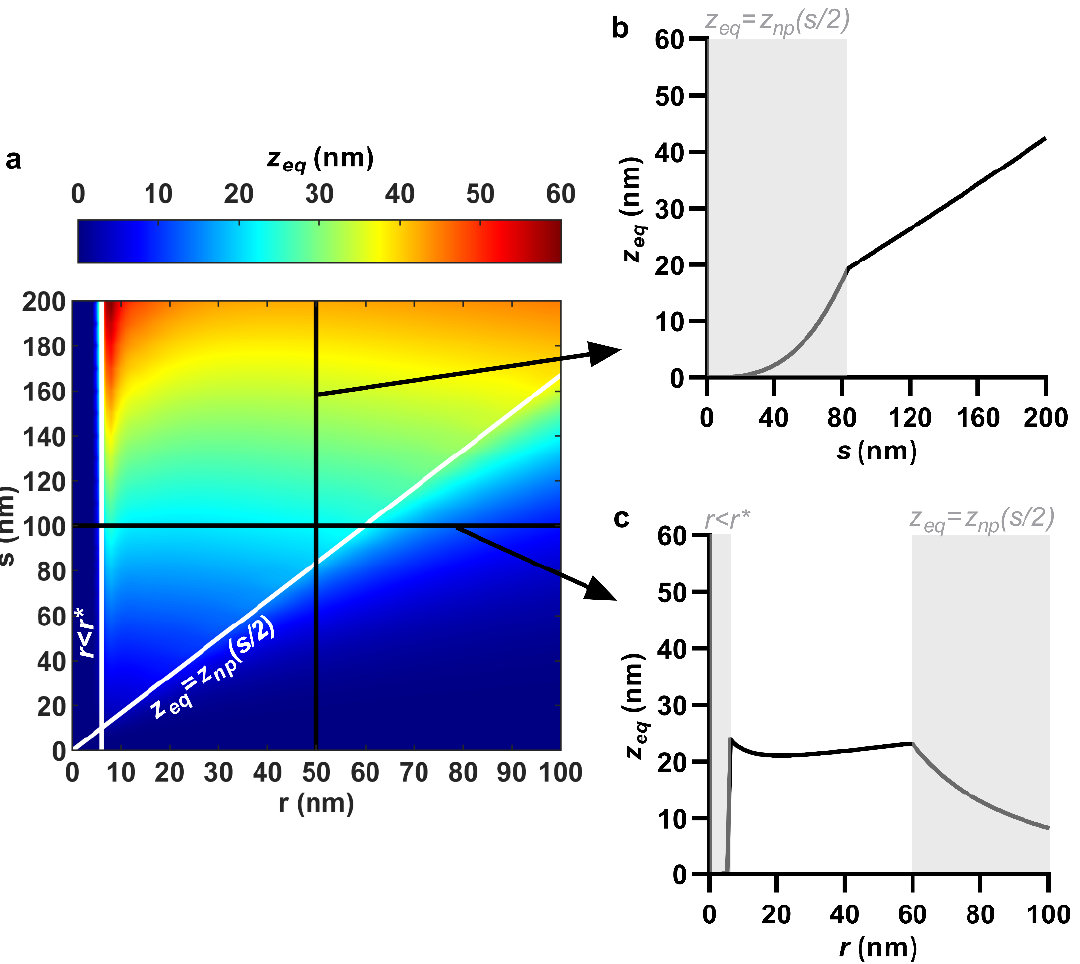
Figure 2. Effect of nanopillar quasi-tip radius, r , and center spacing, s , on equilibrium sinking depth, z eq . ( a ) Combined effects of quasi-tip radius and center spacing shown as a contour plot; ( b ) Selective effect of center spacing, at a fixed quasi-tip radius of 50 nm; ( c ) Selective effect of quasi-tip radius, at a fixed center spacing of 100 nm. r < r* and z eq = z np ( s /2) indicate discontinuities due to emergence of a bending energy barrier and closing of interspace, respectively. For all cases, nanopillar height, pattern ordering, and work of adhesion were 200 nm, hexagonal and 20 mJ/m 2 , respectively. Quasi-tip radius, on the other hand, had a much shallower, non-monotonic effect on sinking depth. That being said, tip radii below a certain value would cause sinking depth to plumet to zero (due to the creation of an antiadhesive energy barrier) and tip radii